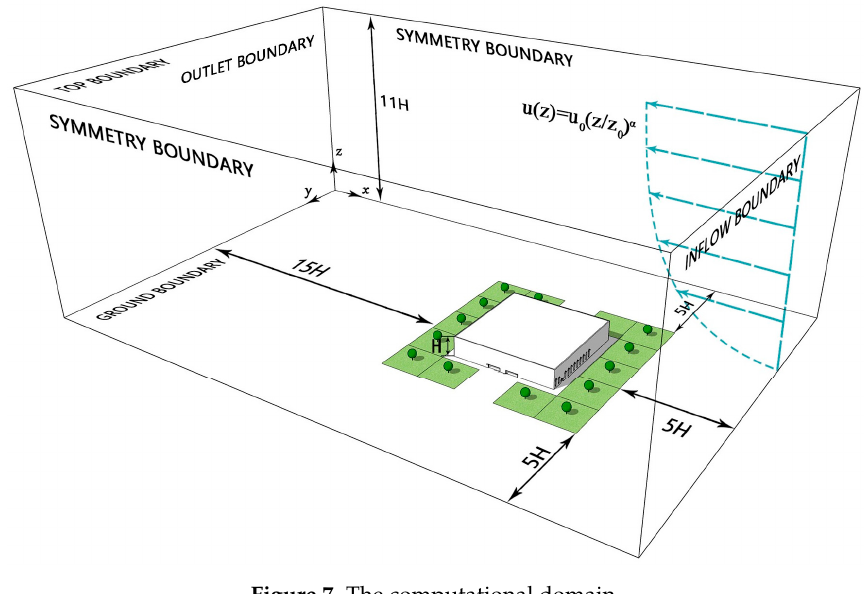
Figure 7. The computational domain. Table 1. Boundary conditions setting